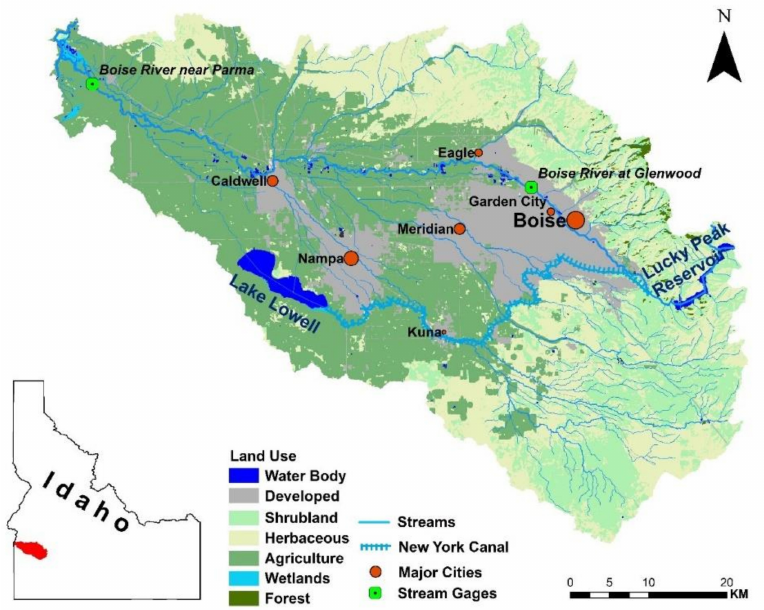
Figure 1. Study area: Treasure